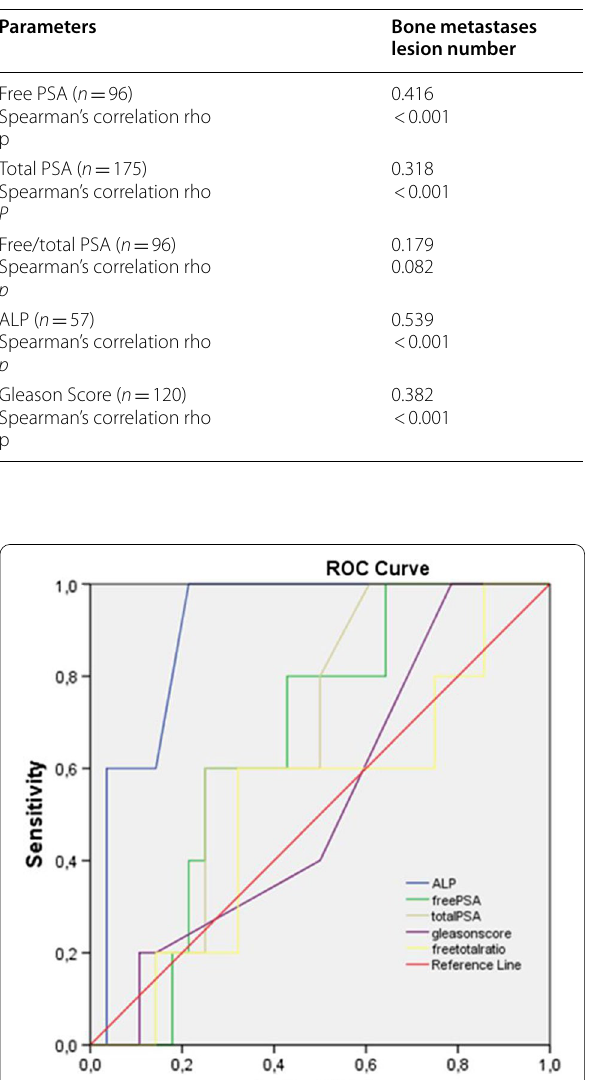
Table 2 Spearman’s correlation coefficients of bone metastases lesion number and some laboratory parameters.